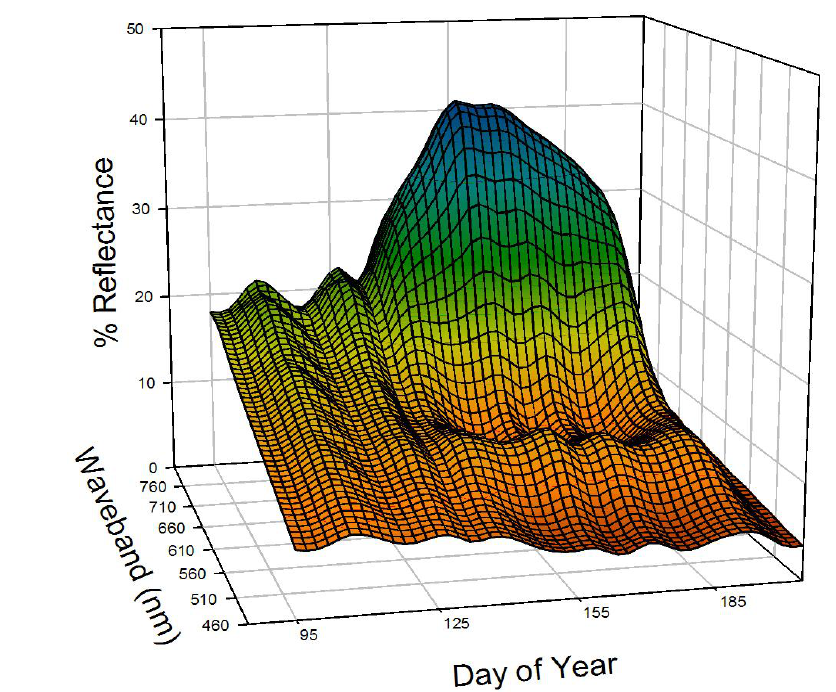
Figure 5. Reflectance over canola during the 2007 growing season obtained with a CropScan eight-band